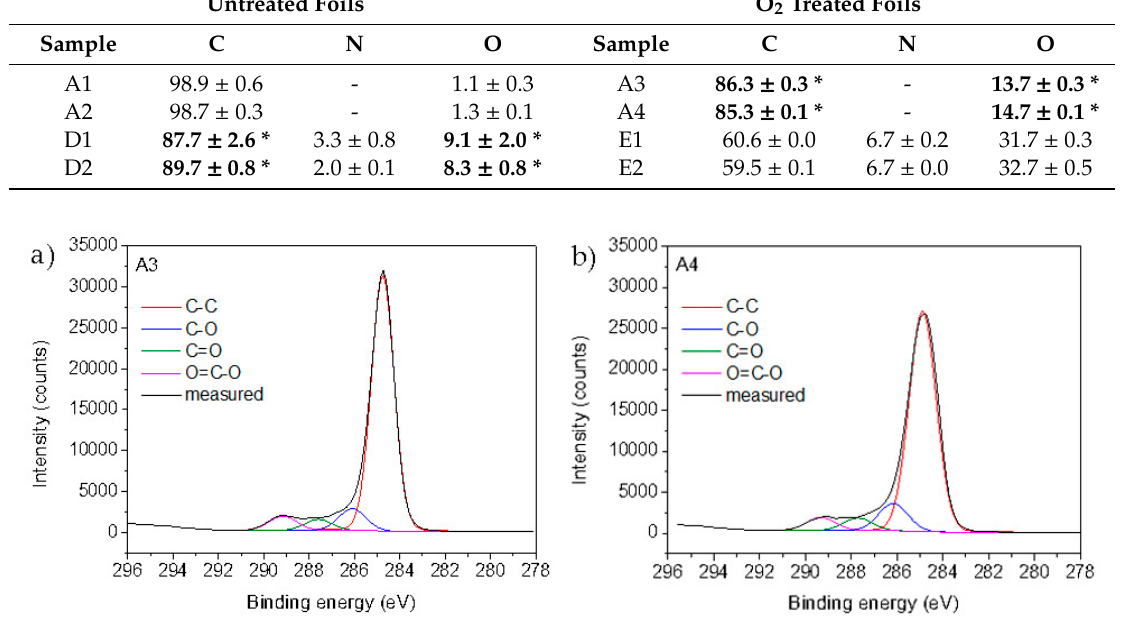
Figure 4. High-resolution carbon C1s spectrum of plasma-treated ( a ) PE and ( b ) PP samples.